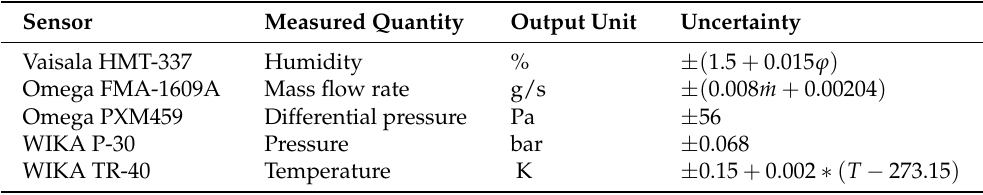
Table 2. Sensors used in the humidifier test stand and their specified measurement